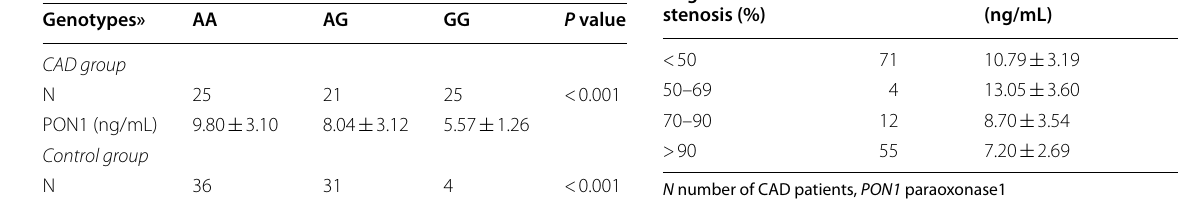
Table 4 Correlation of serum PON1 levels with genotypes of PON1 rs662 gene polymorphism in CAD patient and control group Genotypes»